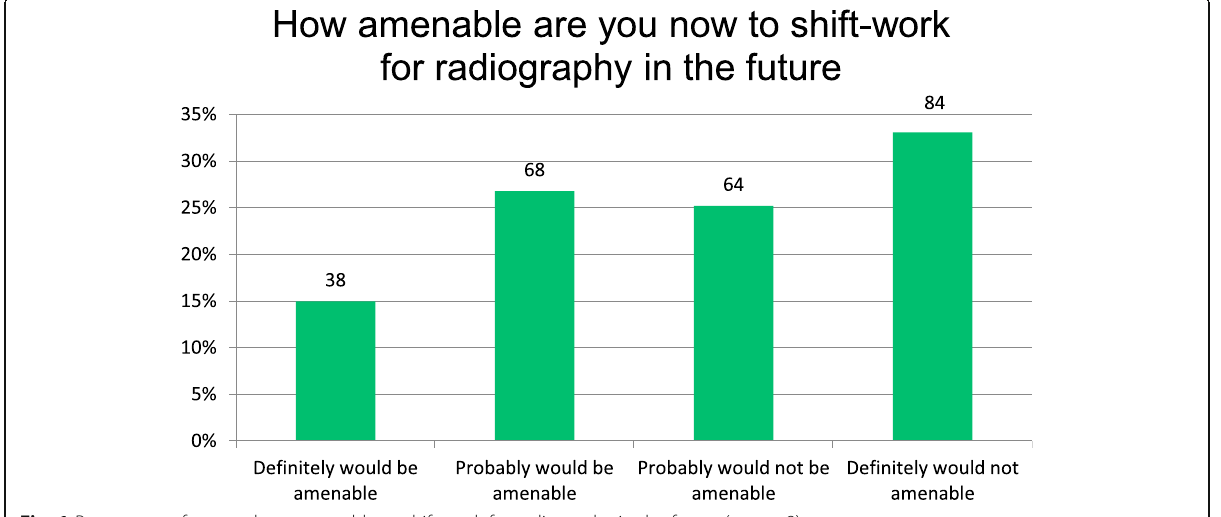
Fig. 1 Percentage of respondents amenable to shift-work for radiography in the future (survey